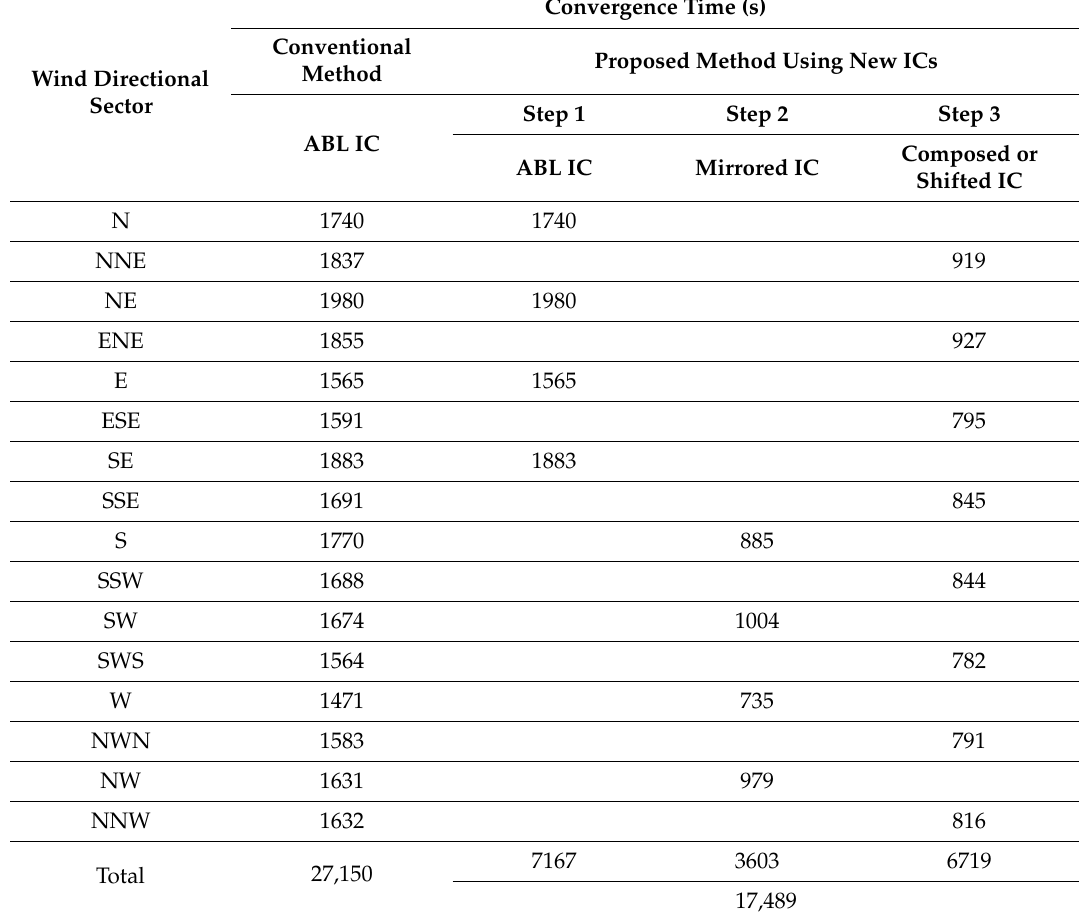
Table 2. Comparison of the convergence times of the 16 wind direction cases between the conventional initial condition (IC) and the proposed